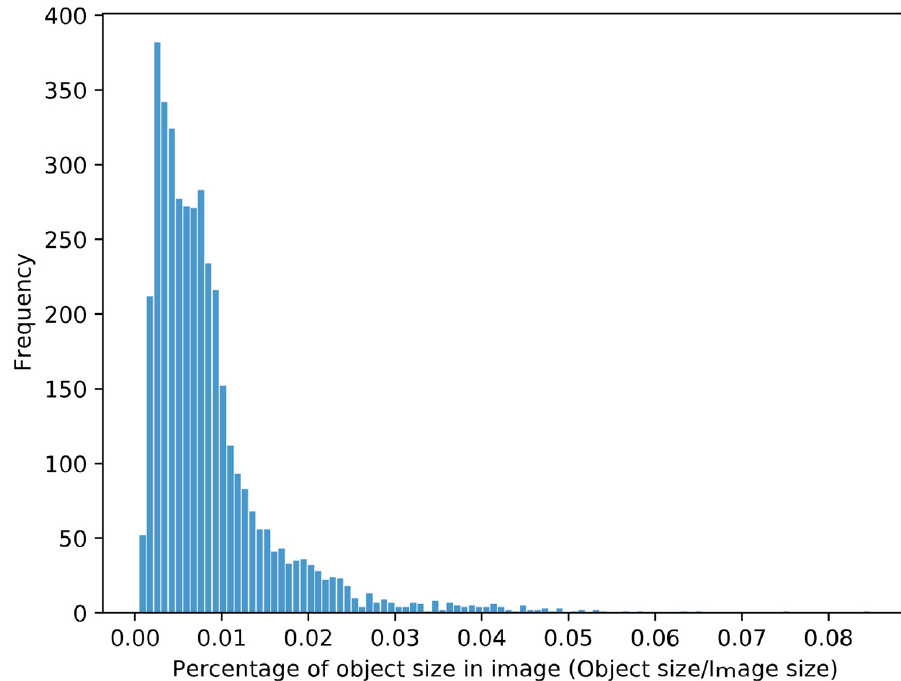
Figure 5. Histogram showing percentage of object size in image for UED dataset.